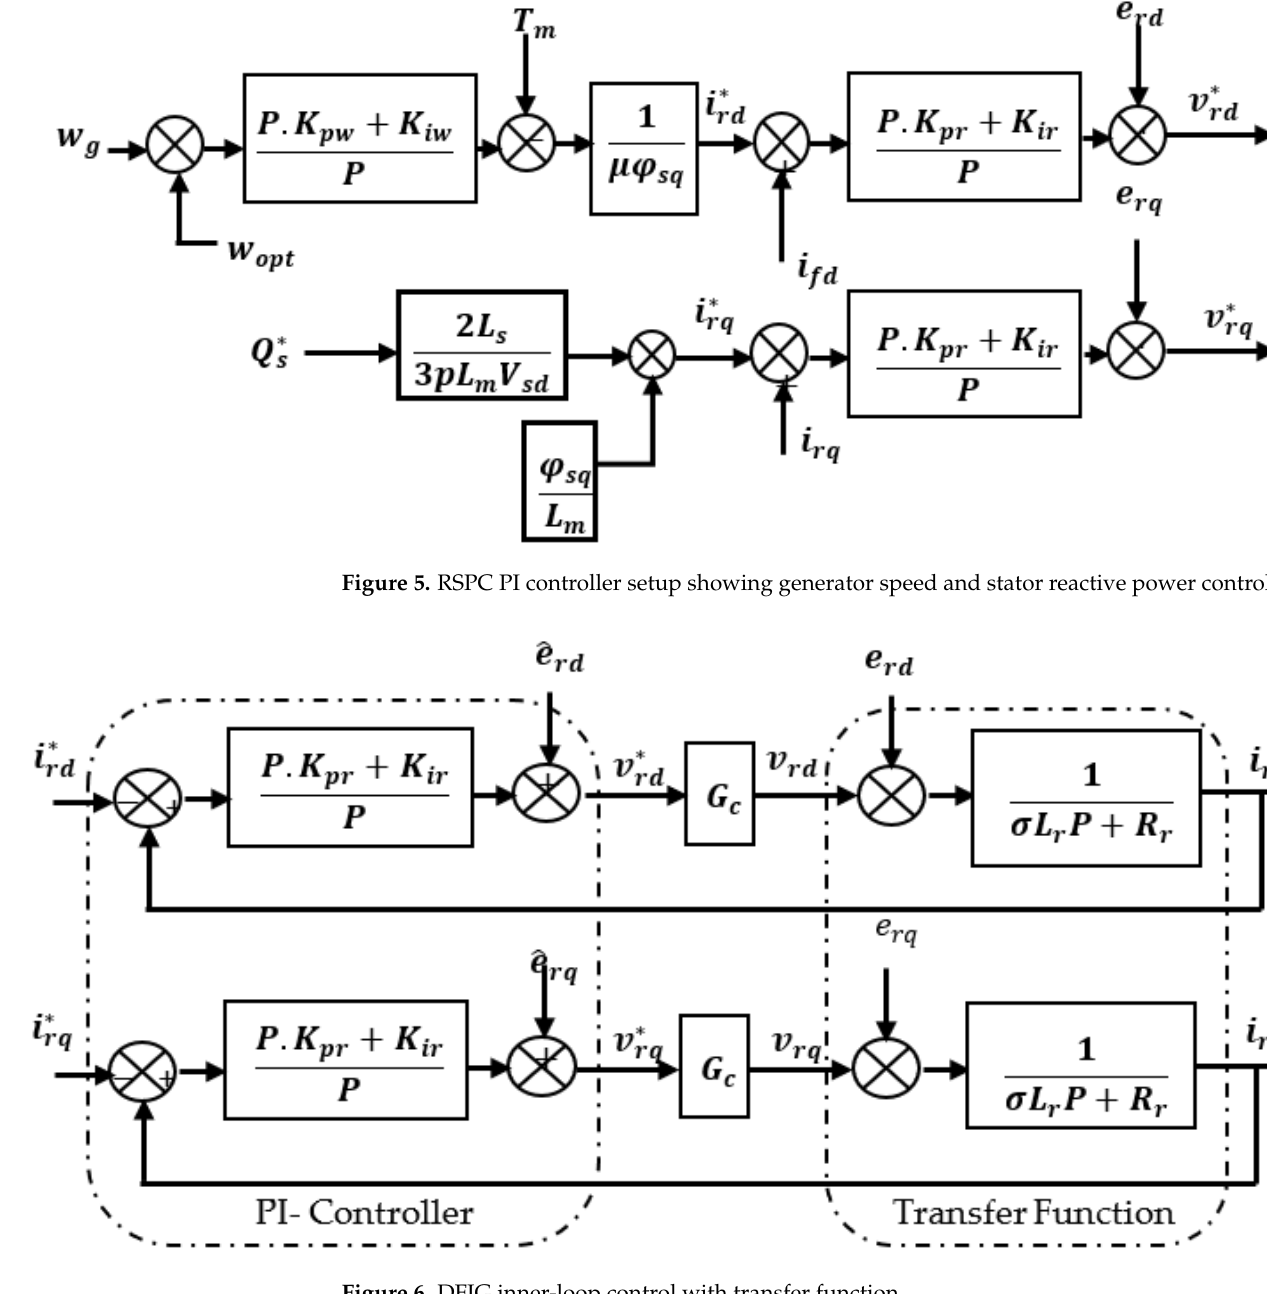
Figure 6. DFIG inner-loop control with transfer function.